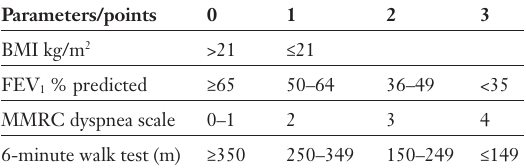
Patients with a BODE index of 7 to 10 or at least 1 of the following: Criteria for listing lung recipient candi- History of hospitalisation for exacerbation associated dates among COPD with acute hypercapnia (PCO 2 >50 mm Hg/6.7 kPa) patients [18]. Pulmonary hypertension or cor pulmonale, or both, despite oxygen therapy.